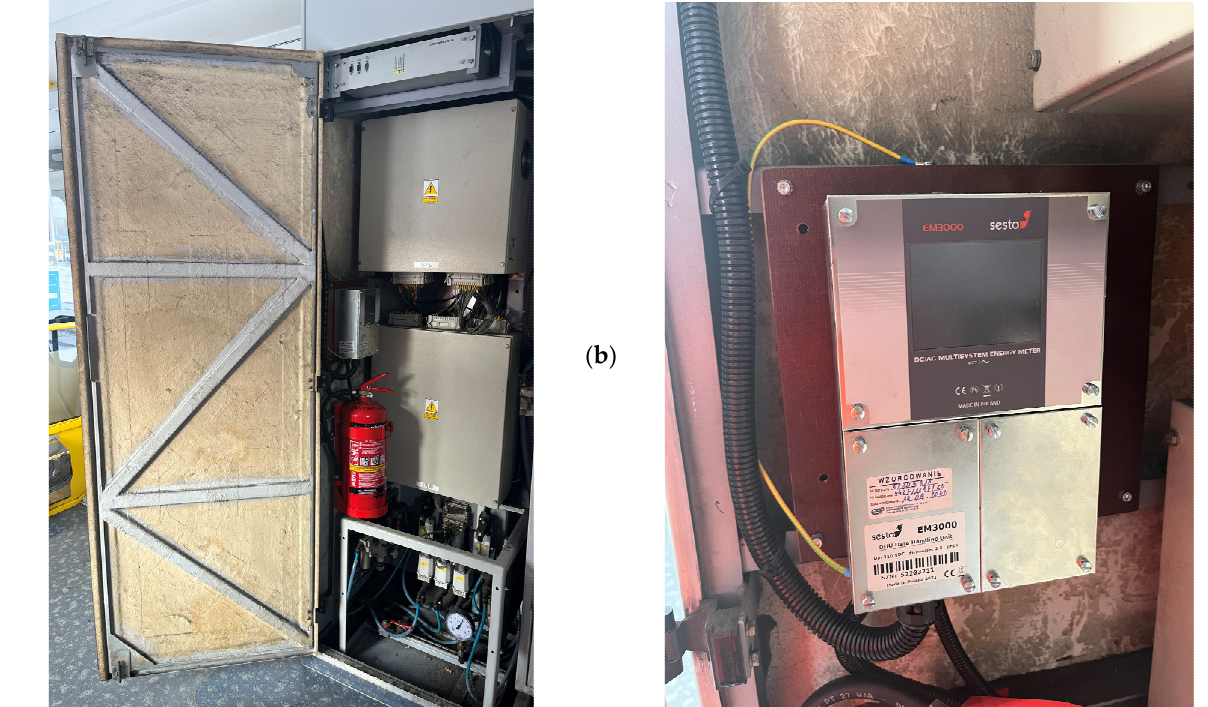
Figure 4. EN57AK Ś -223 series EMU electrical apparatus compartment: ( a ) position of the apparatus; ( b ) electricity meter EM3000.